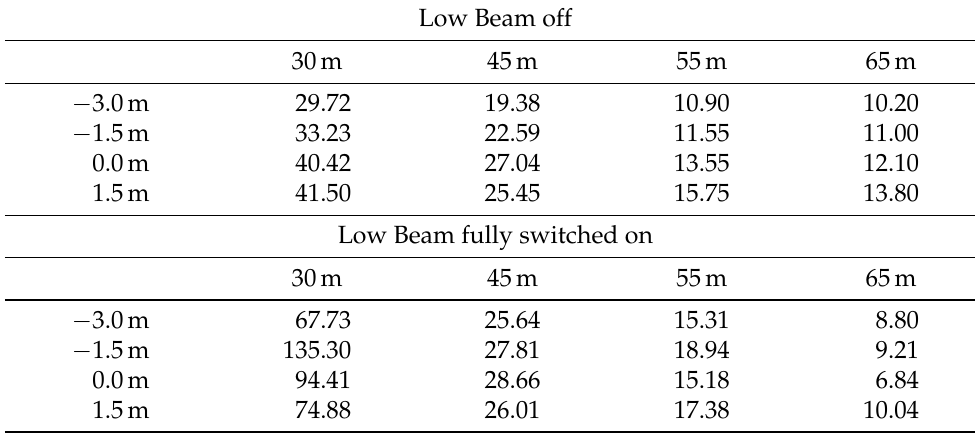
Table 6. Calculated Visibility Levels for test road 3, vehicle position